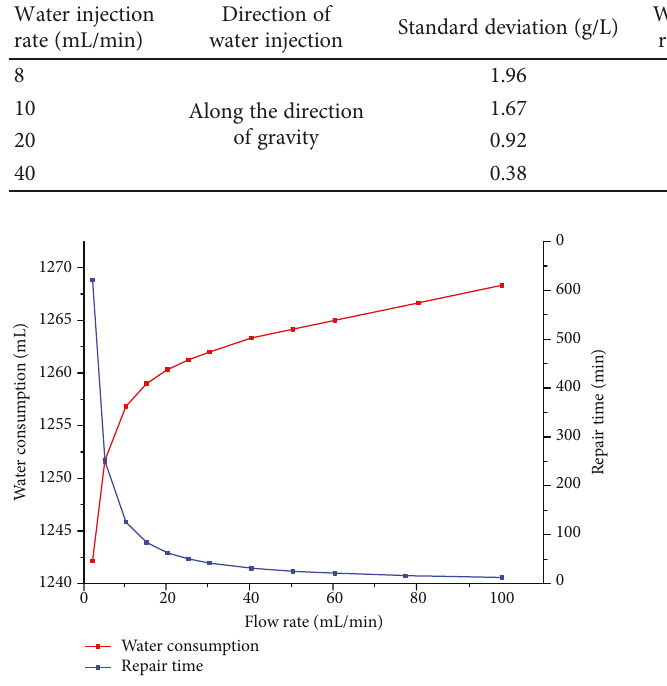
Figure 11: Simulation of repair time and water consumption with fl ow